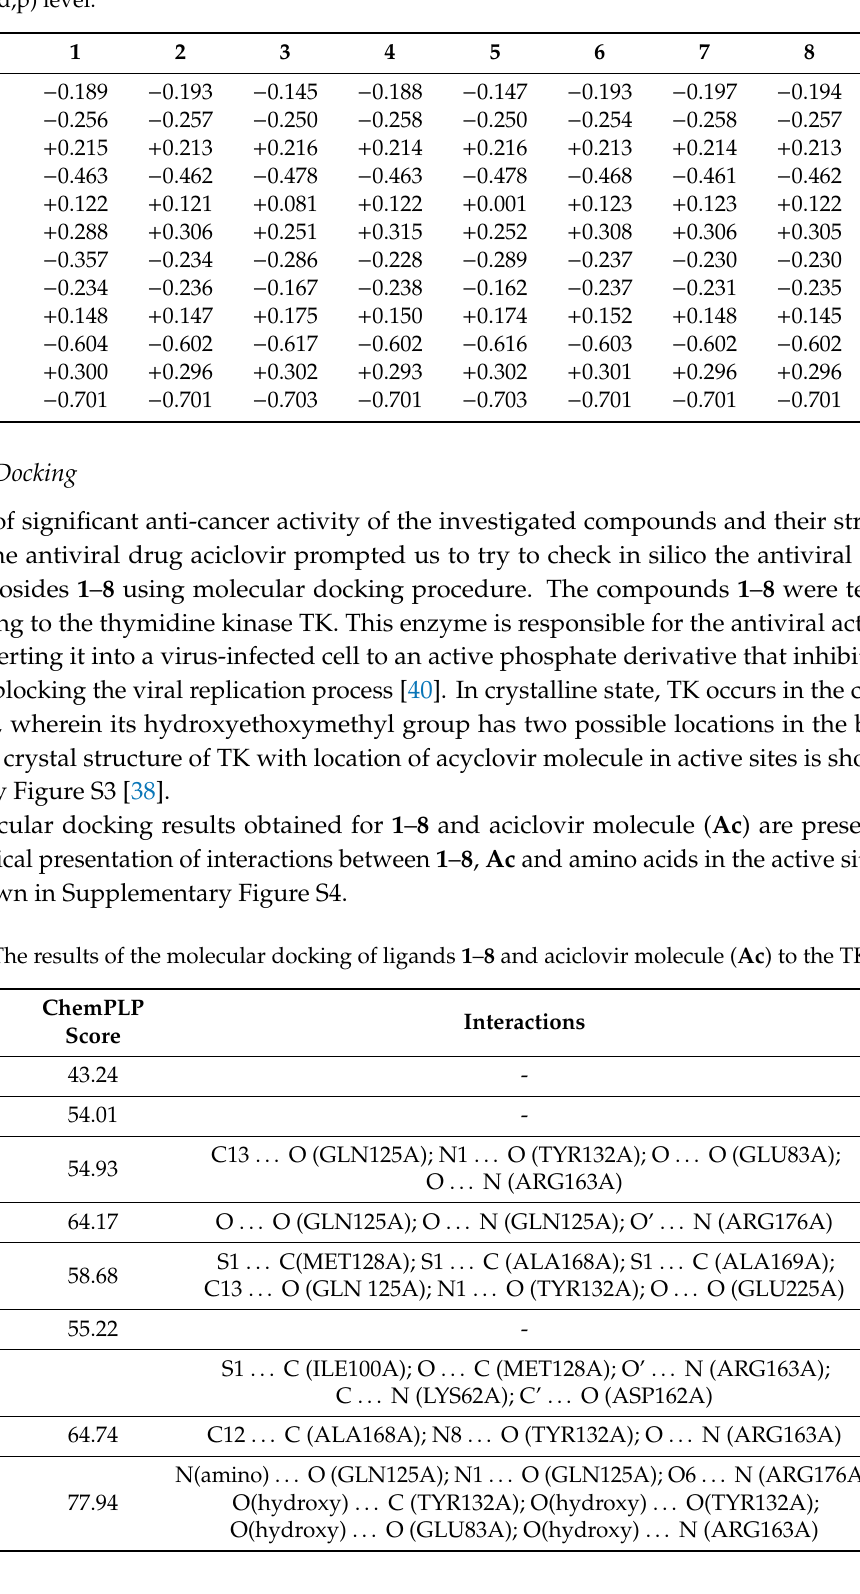
Table 5. Net atomic charges ( e ) on the atoms in the 3-methyl–5-methylsulfanyl-1 H -pyrazolo[4,3-